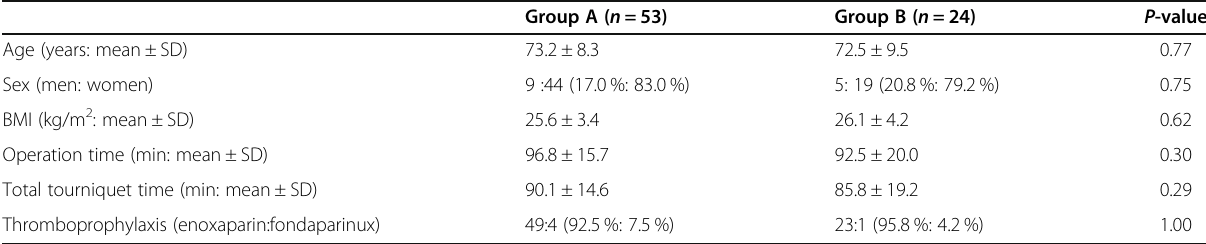
Table 1 Comparison of the patient characteristics between groups A and